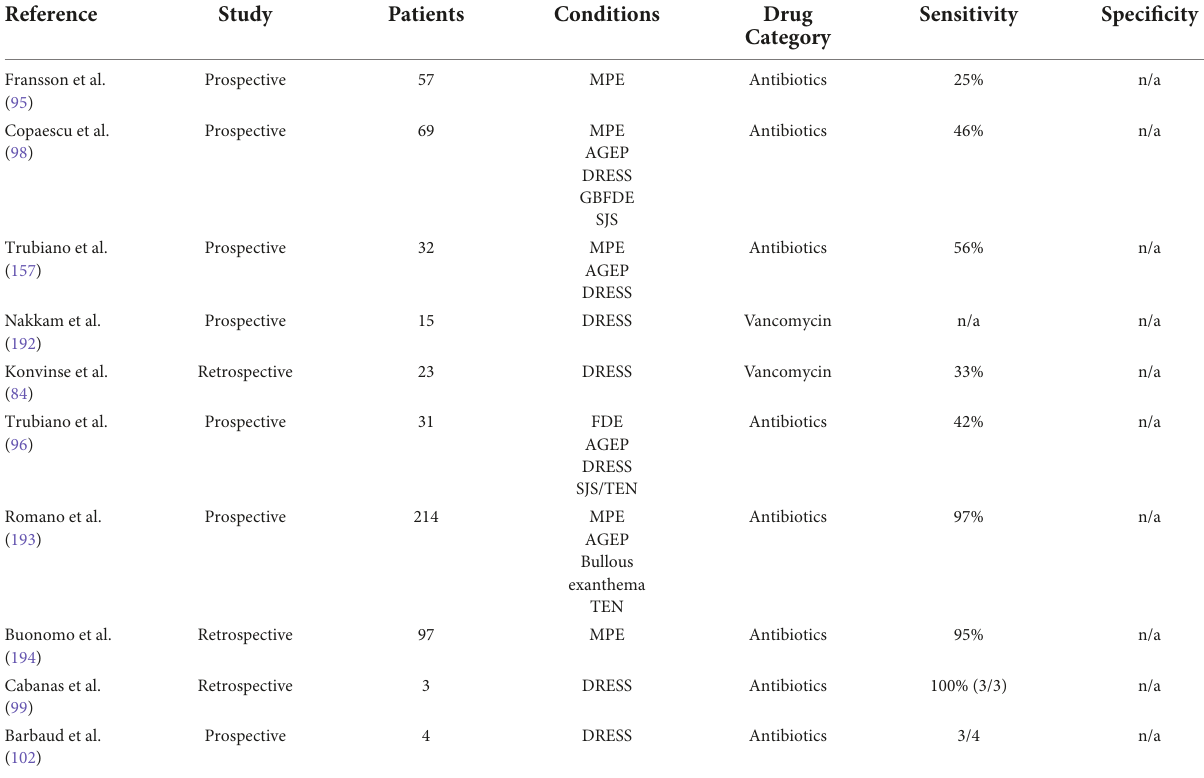
TABLE 2 Recent reported sensitivity and specificity for delayed intradermal testing in drug